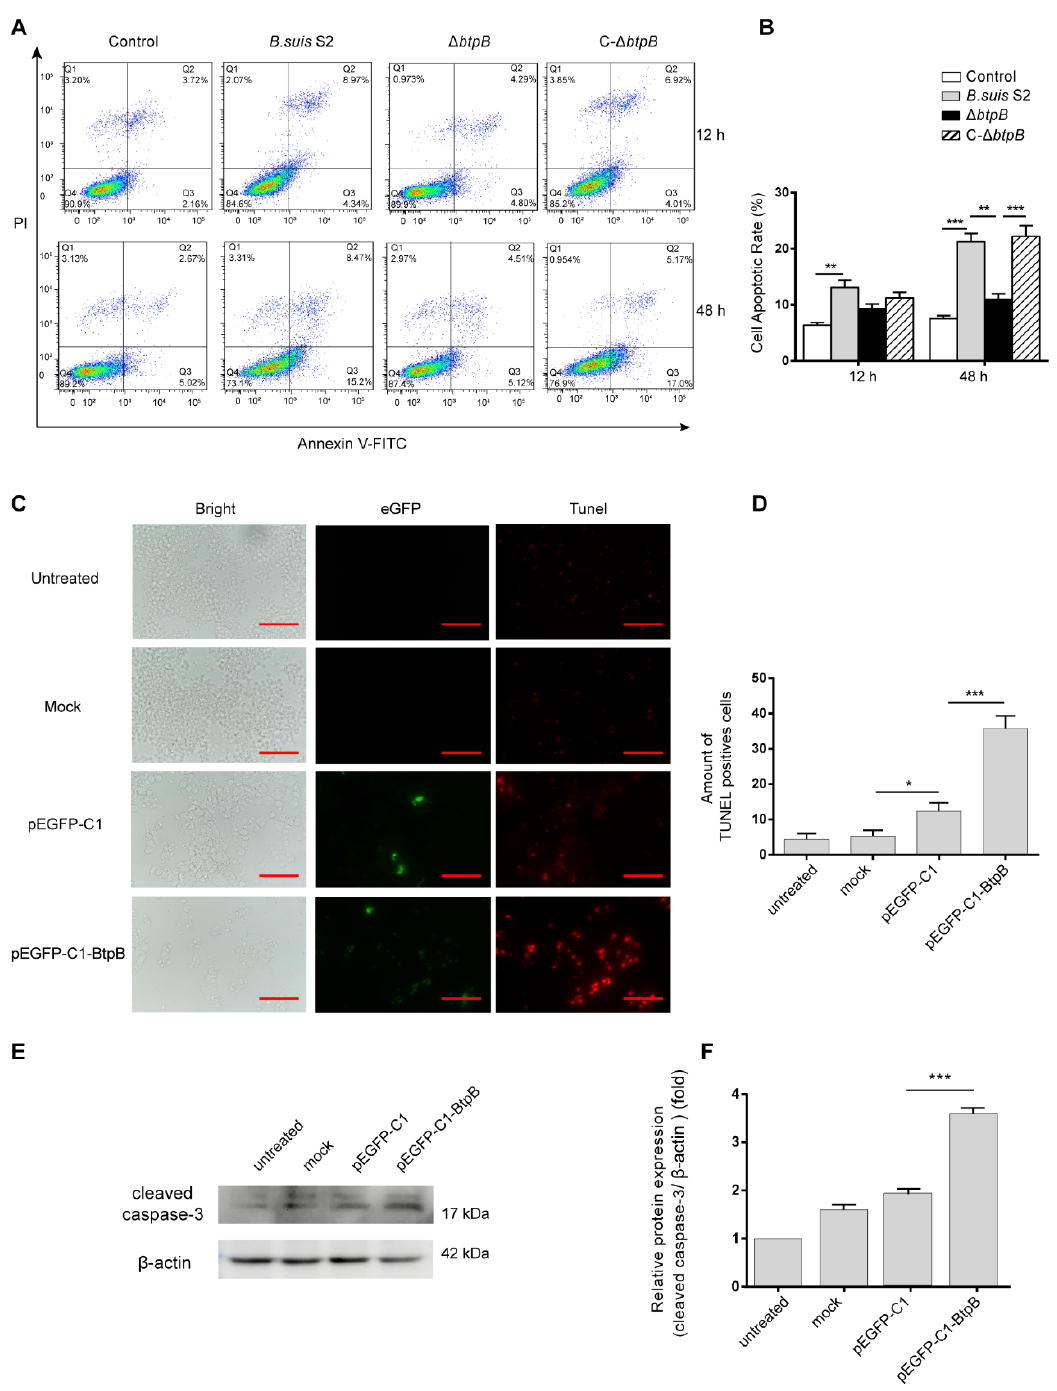
Figure 1. BtpB induces apoptosis in RAW264.7. ( A ) RAW264.7 cells were infected with B. suis S2, ∆ btpB , or C- ∆ btpB (MOI = 200) for 12 and 48 h. The cells were stained with Annexin V-FITC and PI and then detected by flow cytometry. ( B ) Percentage of apoptotic cells. ( C ) RAW264.7 cells were transfected with pEGFP-C1 or pEGFP-C1-BtpB for 48 h and were labeled with TUNEL. Scale bars, 100 μm. ( D ) Number of TUNEL-positive cells at the indicated times. ( E ) RAW264.7 cells were transfected with pEGFP-C1 or pEGFP-C1-BtpB for 48 h and the cleaved caspase-3 and β -actin were detected by immunoblotting analysis. ( F ) The ratio of cleaved caspase-3 relative to β -actin levels was calculated using ImageJ. The experiment was repeated three times and data represent mean ± SD. Results were analyzed with one-way ANOVA and post-hoc Bonferroni multiple comparison test. * p < 0.05; ** p < 0.01; *** p < 0.001.